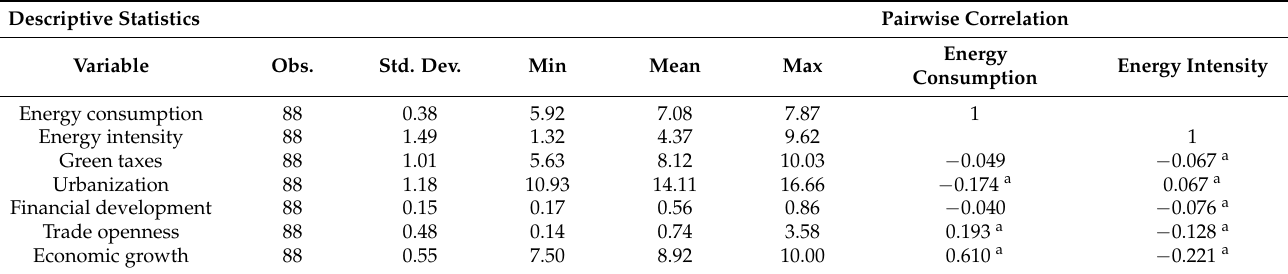
Table 2. Descriptive statistics and pairwise